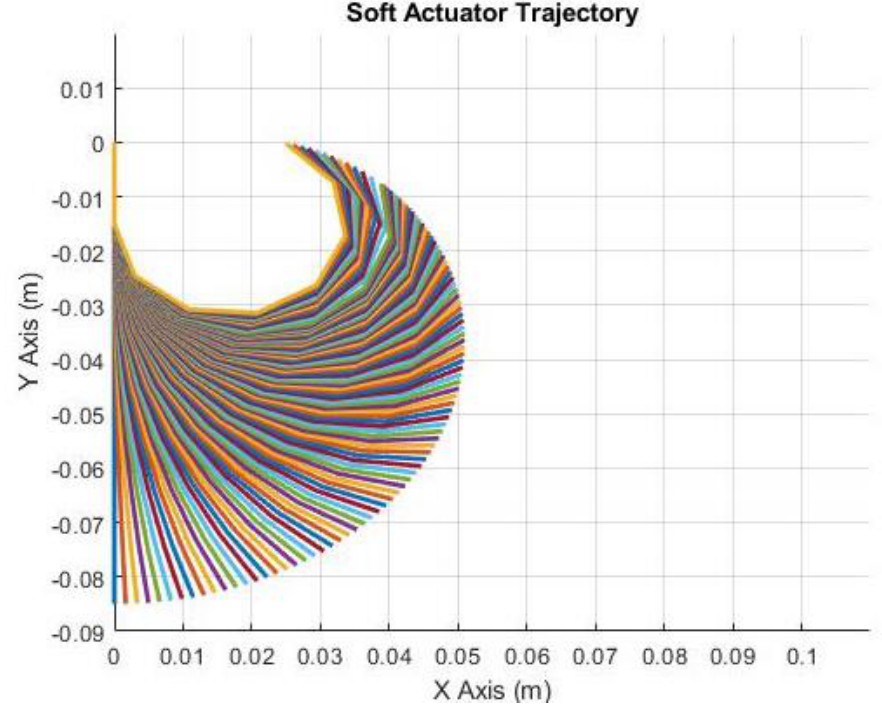
Figure 12. Instances of positions spaced as more energy is introduced to the